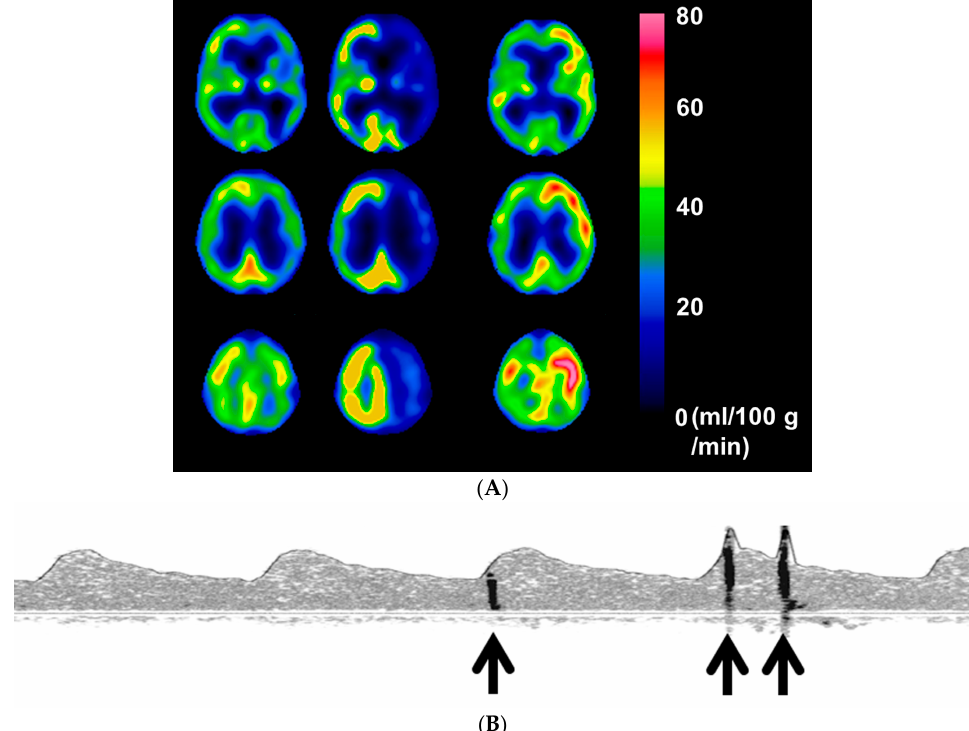
Figure 3. Cont. Figure 3.